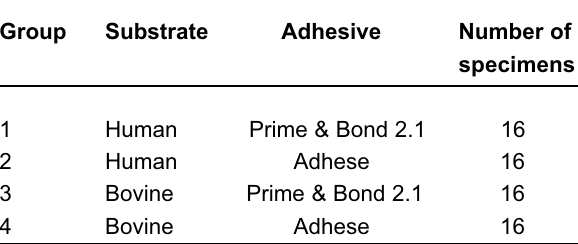
TABLE 1- Distribution of the groups according to the adhesive systems and